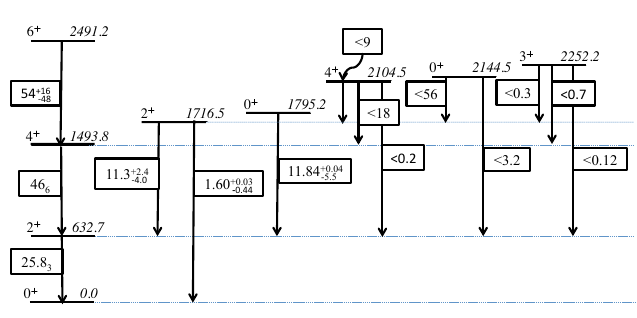
Figure 3. Low-lying portion of the 106 Cd level scheme. Levels represented in this figure have been interpreted as vibrational phonon states, with the 6 + (2491), 4 + (2105), 3 + (2252), and 0 + (2144) states forming part of the three-phonon quintuplet. The B ( E 2)s from the 2 + and 4 + levels in the figure are from the NDS [9], because the 1 1 lifetimes of these low-lying levels are too long to be determined by the present Doppler-shift attenuation method. The E 2 strengths for the decays from the two-phonon levels and upper limits for the 4 + (2105), 3 + (2252), and 0 + (2144) states were determined using the angular distributions at 2.6 and 3.3